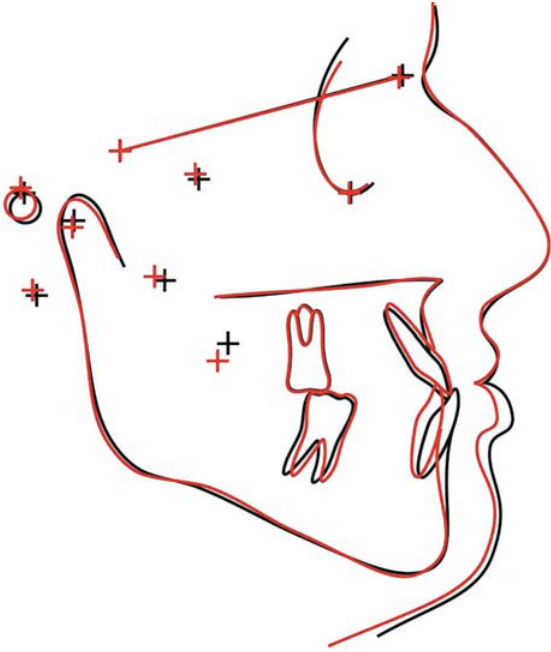
FIGURE 10- Superimposition of cephalometric tracings on SN at S